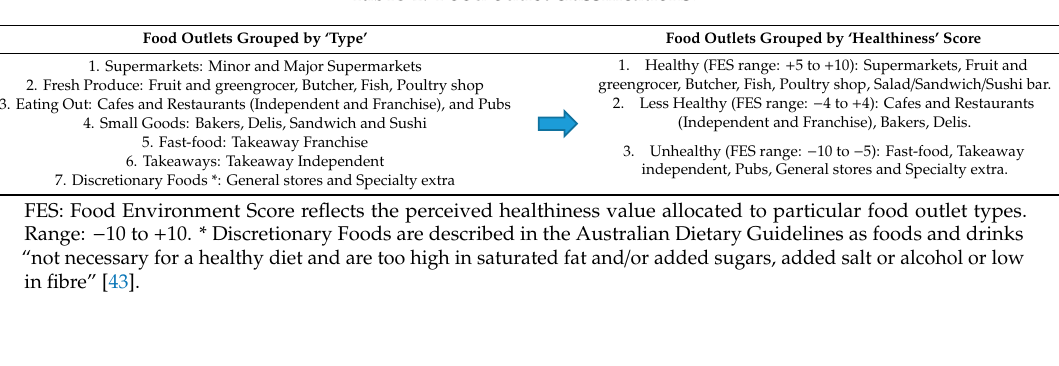
Table 1. Food outlet classifications.